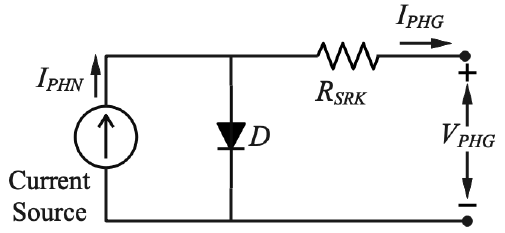
Figure 1. PV cell